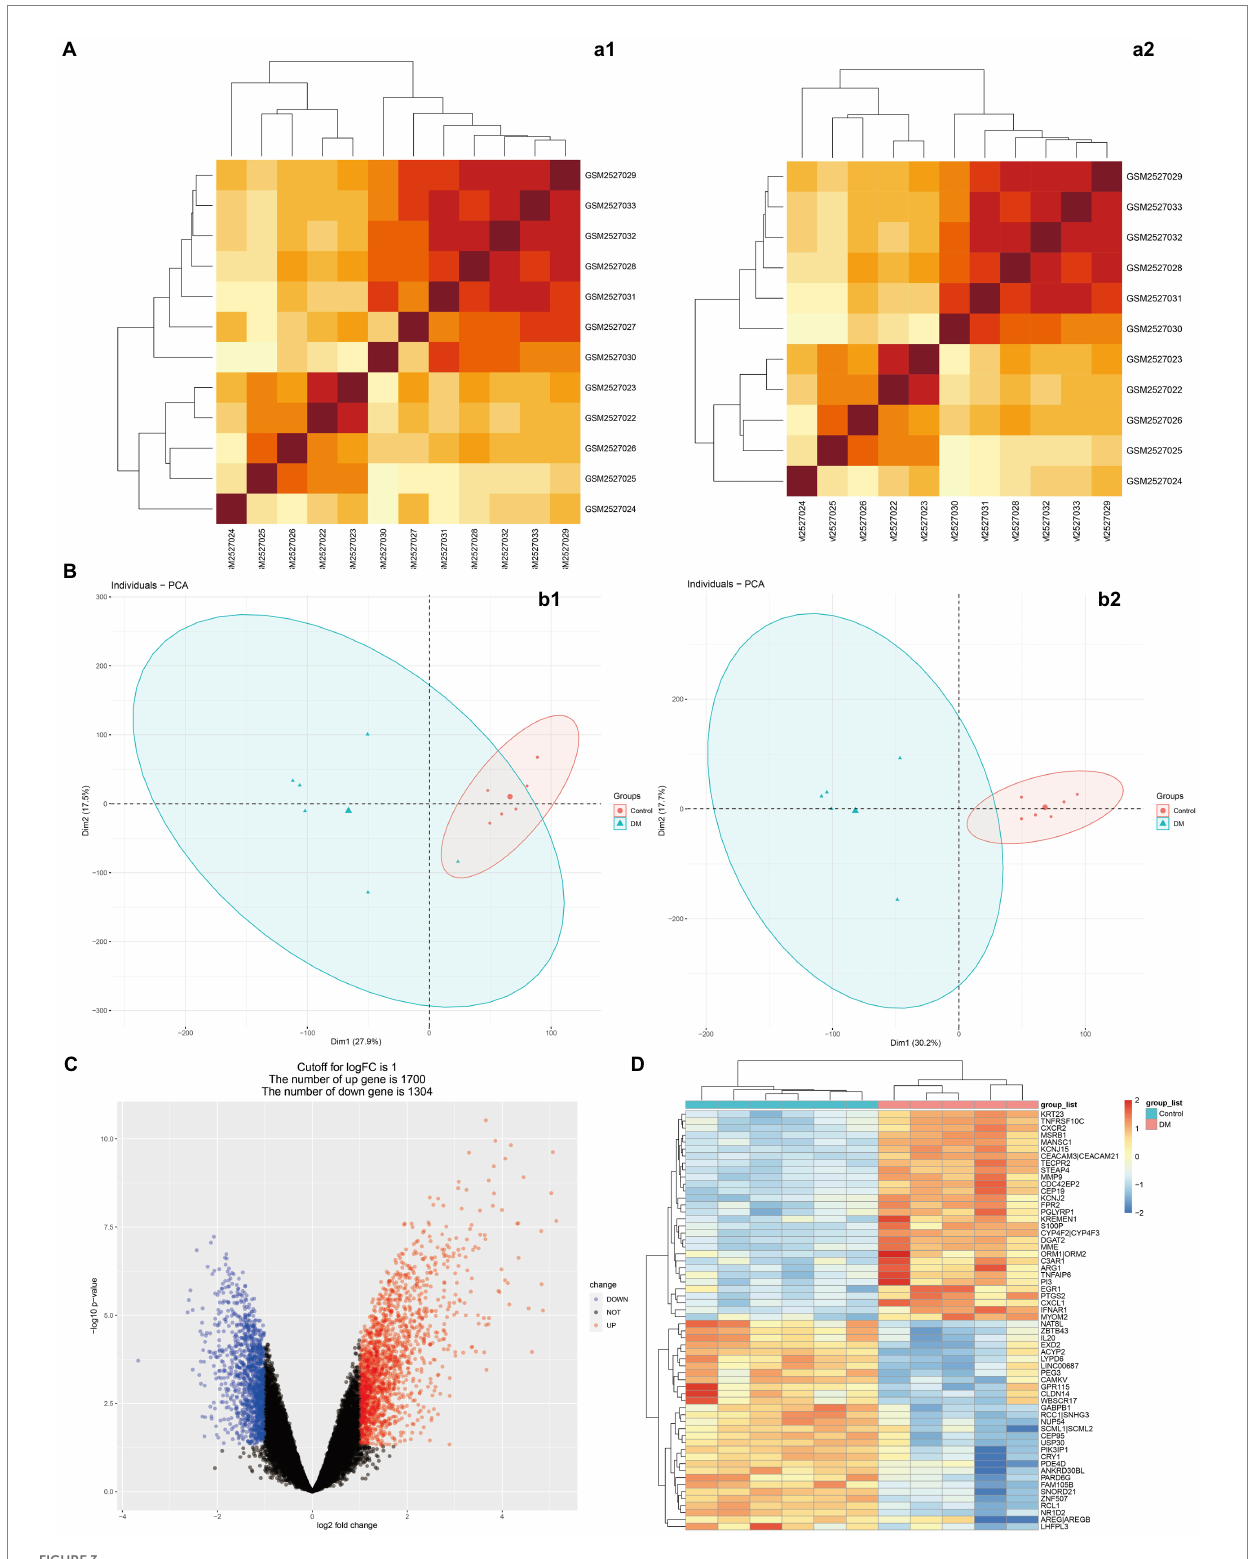
FIGURE 3 Microarray normalization and differential gene analysis in the DM group. (A) The heatmap of DM, (B) The PCA map of DM, (C) The volcano map of DM, and (D) Differential heatmap of partial gene expression between DM and normal group. The data is represented by a1/b1 before processing and a2/b2 after